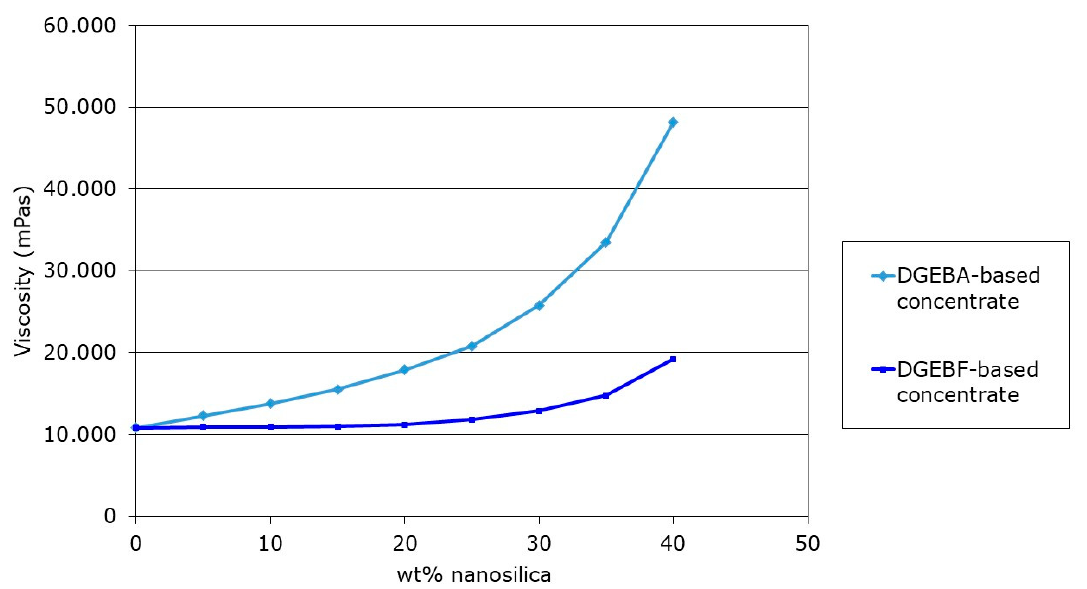
Figure 4. Viscosity increase of a diglycidyl ether of bisphenol A (DGEBA) epoxy resin with increasing nanosilica content using different nanosilica concentrates [4].